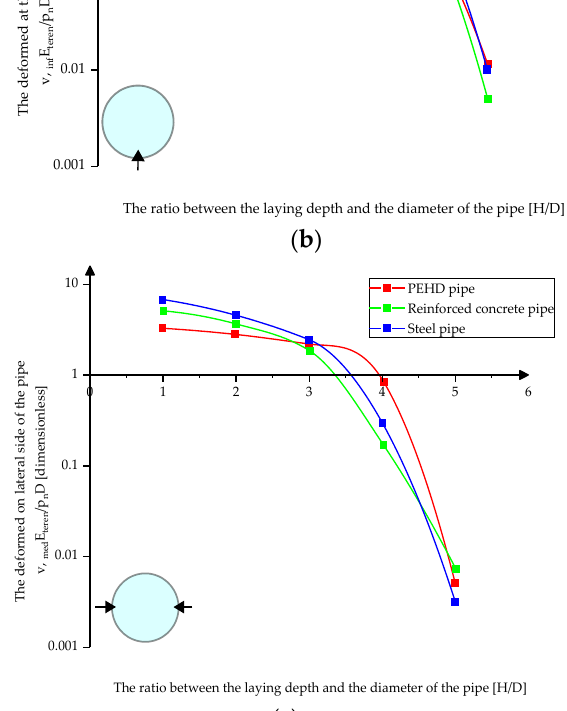
Figure 13. Absolute displacement variation in compacted sand ( a ) at the top of the pipes ( b ) at the bottom of the pipes ( c ) in middle sections.